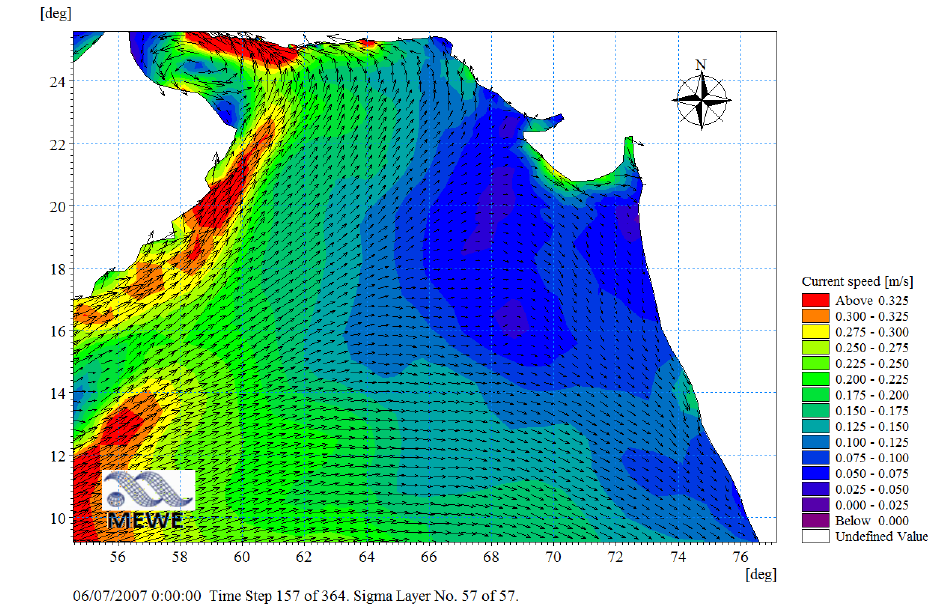
Figure 16. Currents induced by Cyclone Gonu on 7th of June